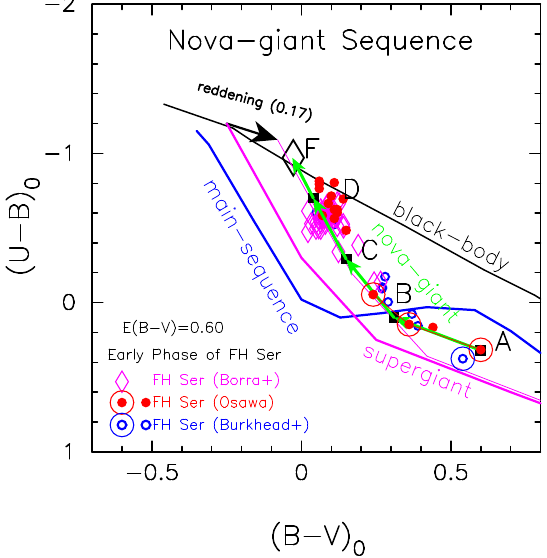
Figure 2: Color-color evolution of FH